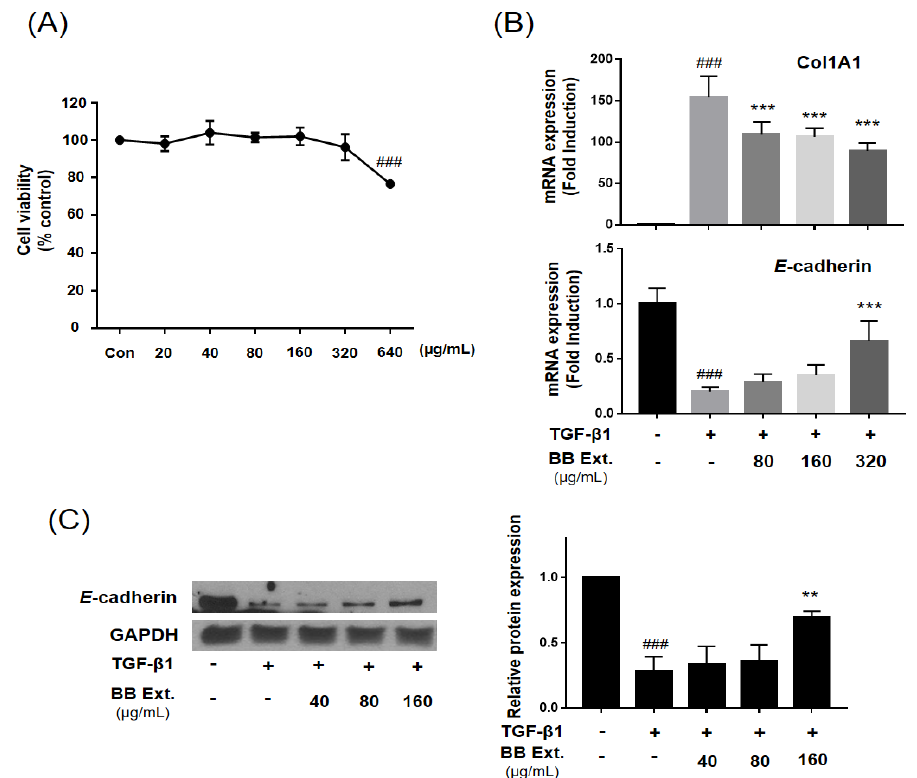
Figure 1. MeOH extract of the culture broth of the entomopathogenic fungus B. bassiana (BB) inhibited TGF- β 1-induced myofibroblast differentiation in alveolar epithelial A549 cells. A549 cells were treated with TGF- β 1 (2 ng/mL) and MeOH extract for 48 h. ( A ) Cytotoxicity of MeOH extract in A549 cells was measured by WST-1 assay at 48 h. ( B ) Expression of collagen (Col1A1) and E -cadherin was analyzed by qPCR-analysis. ( C ) The protein expression of E -cadherin was analyzed by western blot assay. All the assays were performed in triplicate, and the data are shown as the mean value ± S.D. Values that are significantly different from the control are indicated by ### p < 0.001, significantly different from the TGF- β 1-treatment group, ** p < 0.01, or *** p < 0.001.